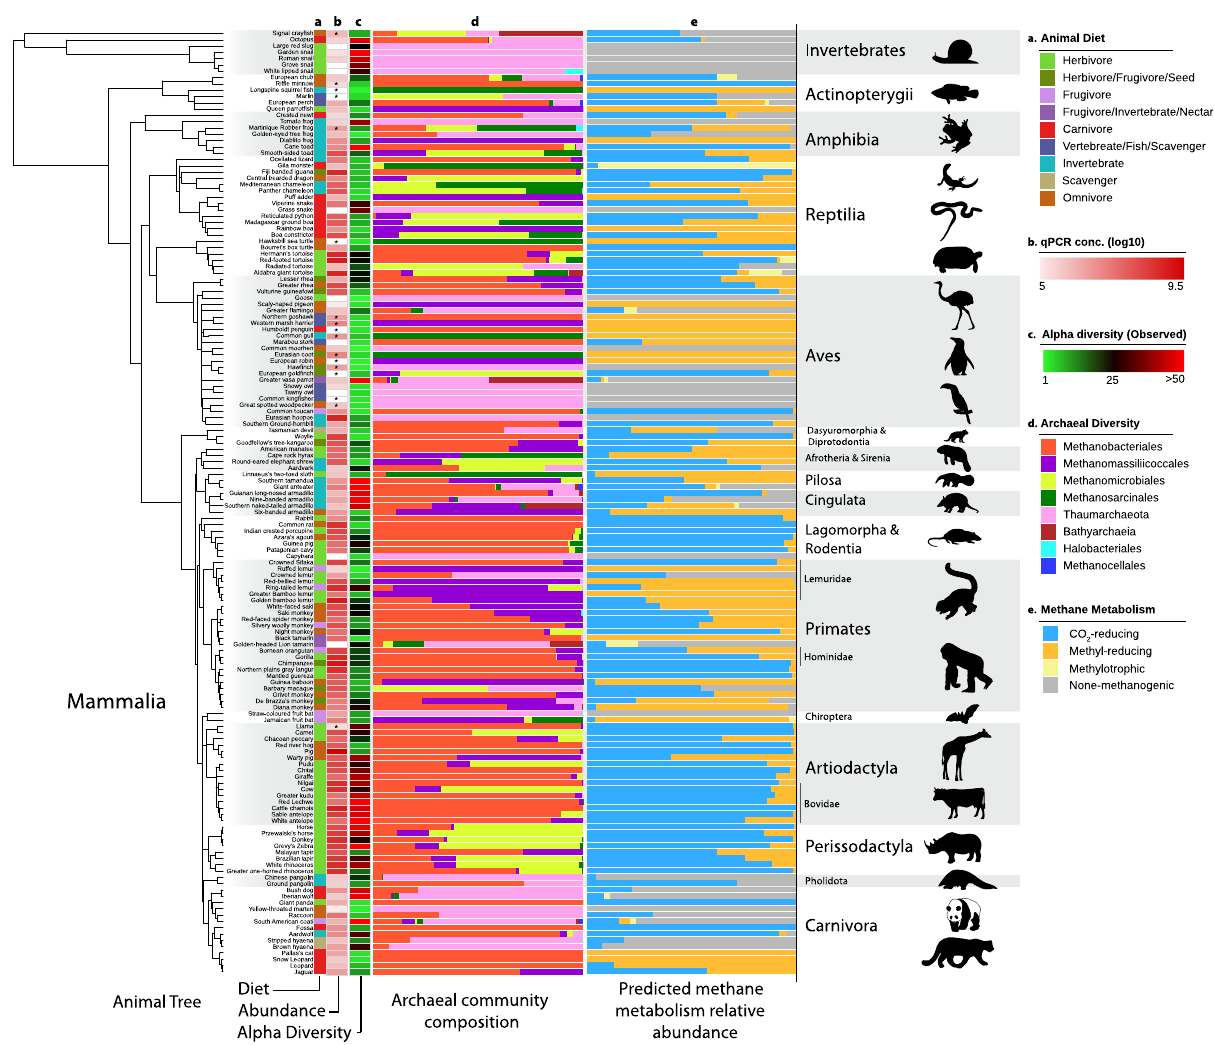
Fig. 3 Archaeal abundance and diversity in the animal gut ( n = 150; species with ≥ 3000 archaeal reads). a Information on animal primary diet gathered using the Elton Trait database, the Animal Diversity Website database, or from specialists who provided faecal samples. Primary diet was considered food material that made up ≥ 70% of the animal ’ s diet. b Absolute abundance of archaea as determined by qPCR with archaea-targeting primers on a log scale. Stars (*) indicate species for which the abundance may be underestimated (see Supplementary Fig. 19). c Observed richness (number of different ASV) of archaea. d Taxonomic diversity of archaea in the animal intestinal microbiome. Samples were rare fi ed to 3000 archaeal reads. e) Proportion of CO 2 - reducing, methyl-reducing and methylotrophic methanogens, as well as non-methanogens in the archaeal community (see Supplementary Table 2 for assignation of metabolisms to taxa). The Animal Tree was generated using Timetree.org 103 between diet types (Supplementary Fig. 12b). The link between methanogen abundance and diet type is further supported by the strong positive correlation of both the absolute and relative abundances of methanogens with the fi bre content of the diet (Fig. 6b; Supplementary Fig. 13), contrasting with the absence of correlation for Thaumarchaeota and Bacteria (Supplementary Fig. 12c and d). The increase in methanogen absolute/relative abundance reaches a limit at around 200 g of crude fi bre/kg of dry matter (Fig. 6b; Supplementary Fig. 13). At a lower host taxo- nomic level, the positive correlation also holds for Primates, for which we sampled species with contrasting average fi bre intake (Fig. 6c). An increased fi bre consumption was previously reported to be associated with a higher expression level of methanogenesis genes in humans 59 and greater methane production in pigs 60 and ruminants 61 . As the vast majority of intestinal methanogens are hydrogenotrophic, these relationships can be explained by the higher production of hydrogen from fi bre/carbohydrates-rich diets (plant) than from protein/fat-rich diets (meat) 62 .